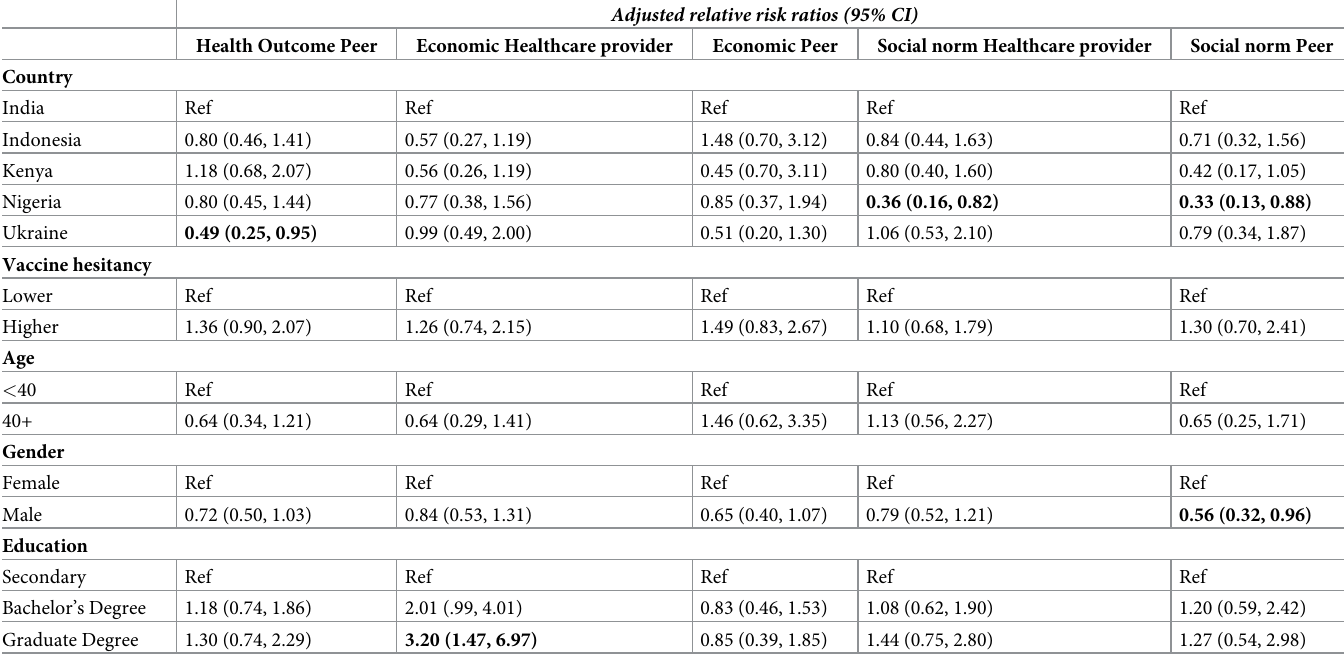
Table 3. Relative risk ratios of ad preference by vaccine hesitancy status and participant characteristics using multivariable multinomial logistic regression model- ing (n = 900 �